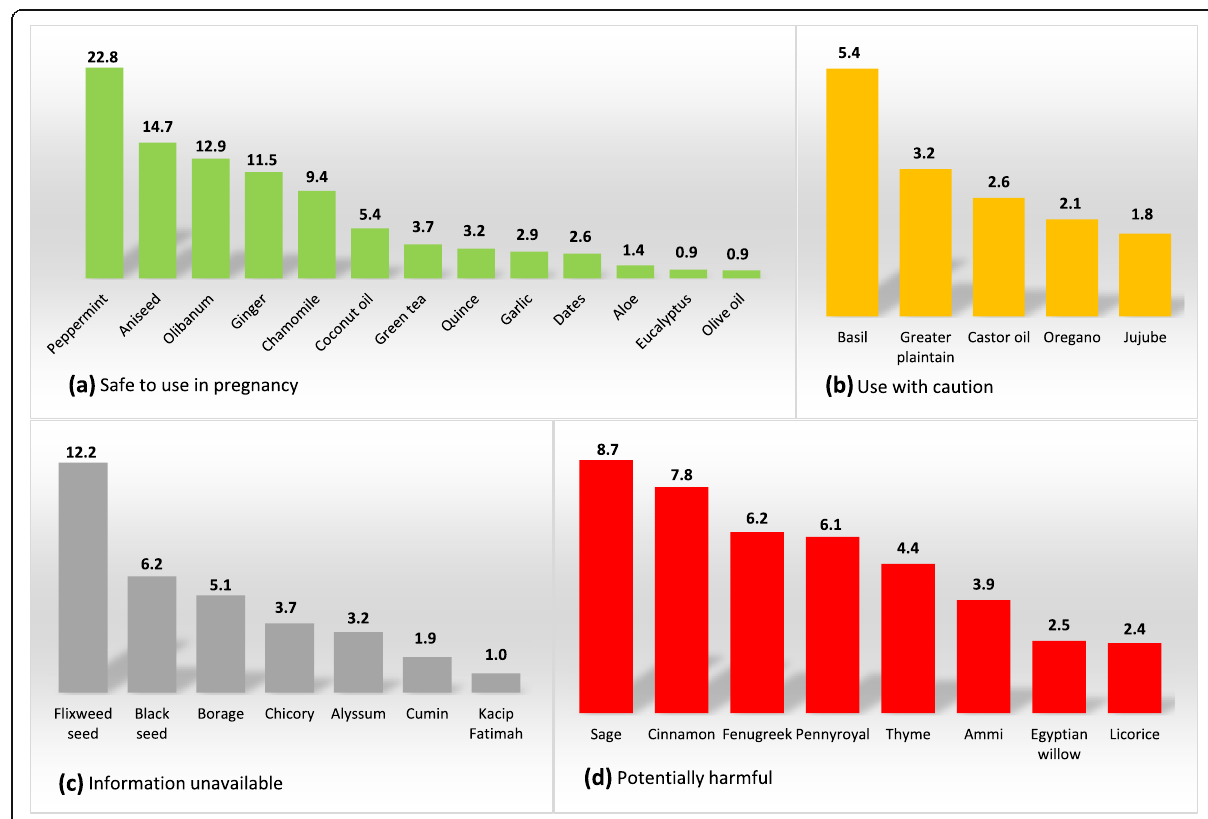
Fig. 2 Frequency of herbal medicines used in pregnancy according to their safety classification. a Herbal medicines in this section are classified as safe to use in pregnancy. b Herbal medicines in this section should not be used without consulting a qualified health care practitioner. c Information on safety for herbal medicines in this section is not available in current literature. d Herbal medicines in this section can be harmful to mother or fetus. Note: Number of herbal medicine users for each type is given in percentage out of total number of